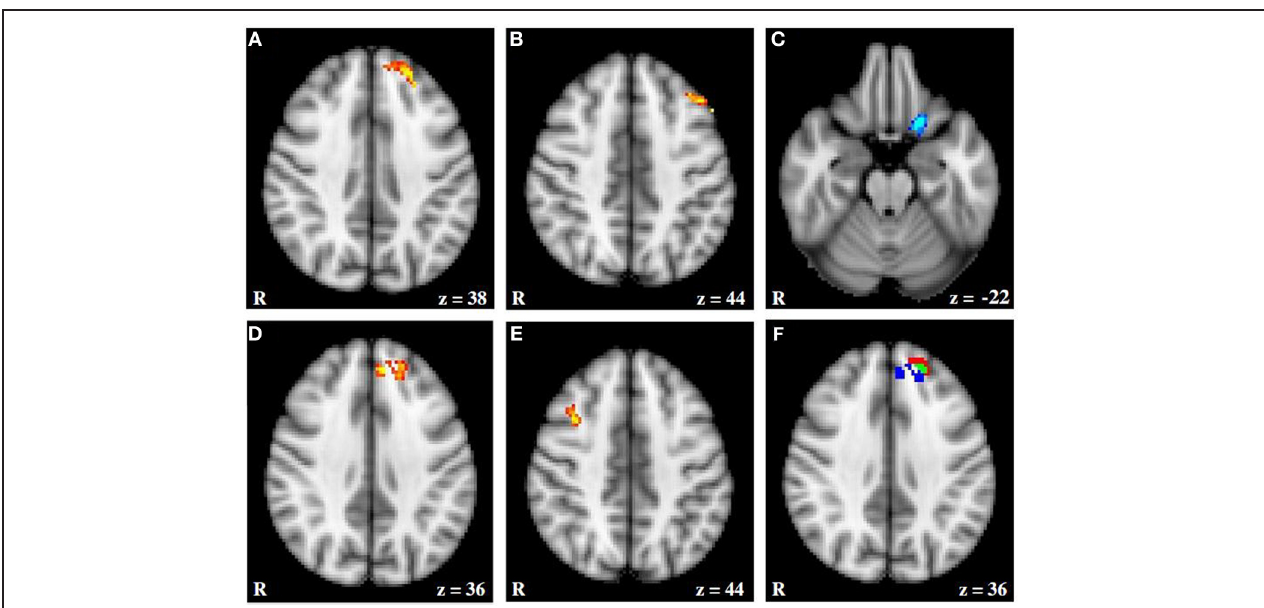
FIGURE 5 | fMRI activation moderated by approach and avoidance temperament. ( A and B ) Activation for Incongruent–Congruent contrast (IvC) correlating positively with approach temperament. (C) Activation for IvC correlating negatively with approach temperament. ( D and E ) Activation for IvC correlating positively with avoidance temperament.